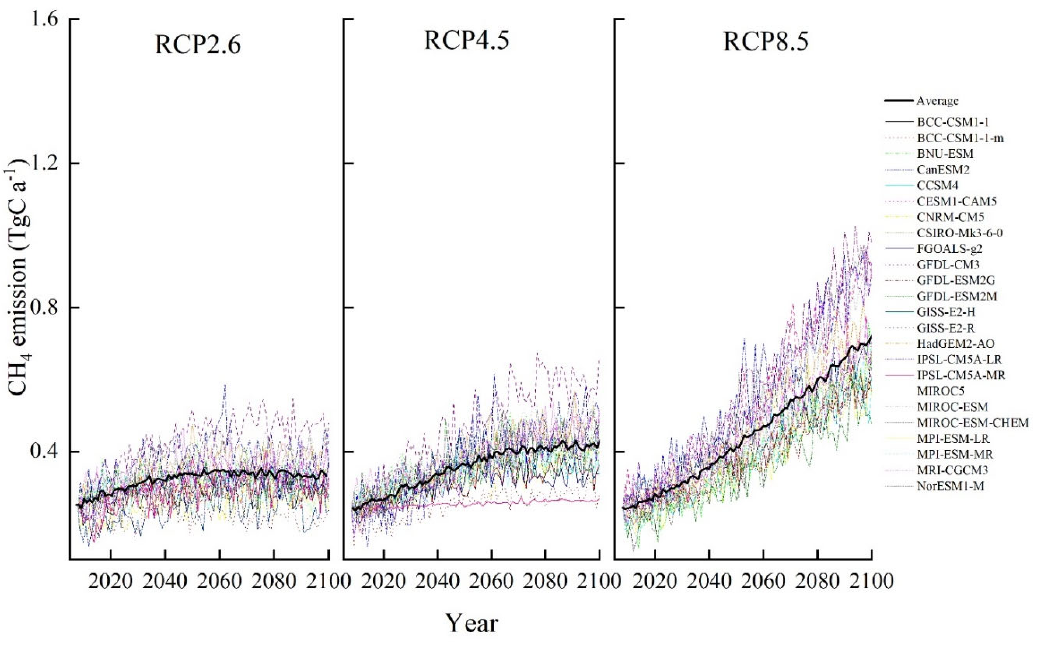
Figure 2. Variation in annual CH 4 emissions from wetlands on the Qinghai–Tibet Plateau during the period 2008–2100. CO 2 concentrations were held constant at 2008 levels. Results for the 24 CMIP5 models are shown, and the thick black line indicates the average across all models.